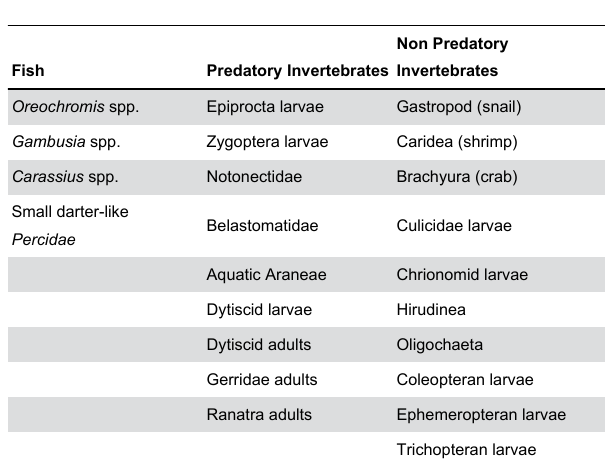
Table 1. Fish, predatory invertebrates, and non-predatory invertebrates identified in breeding site